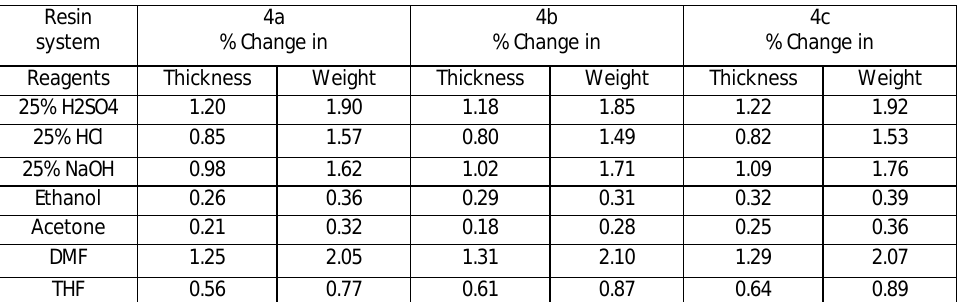
Table Table --33 Chemical properties of glass fibre reinforced composites of UPEA-VA Resin blends.